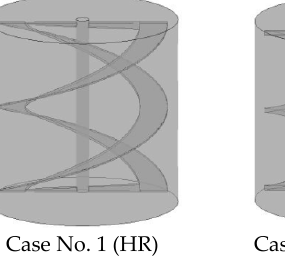
Figure 7. Stirred system.